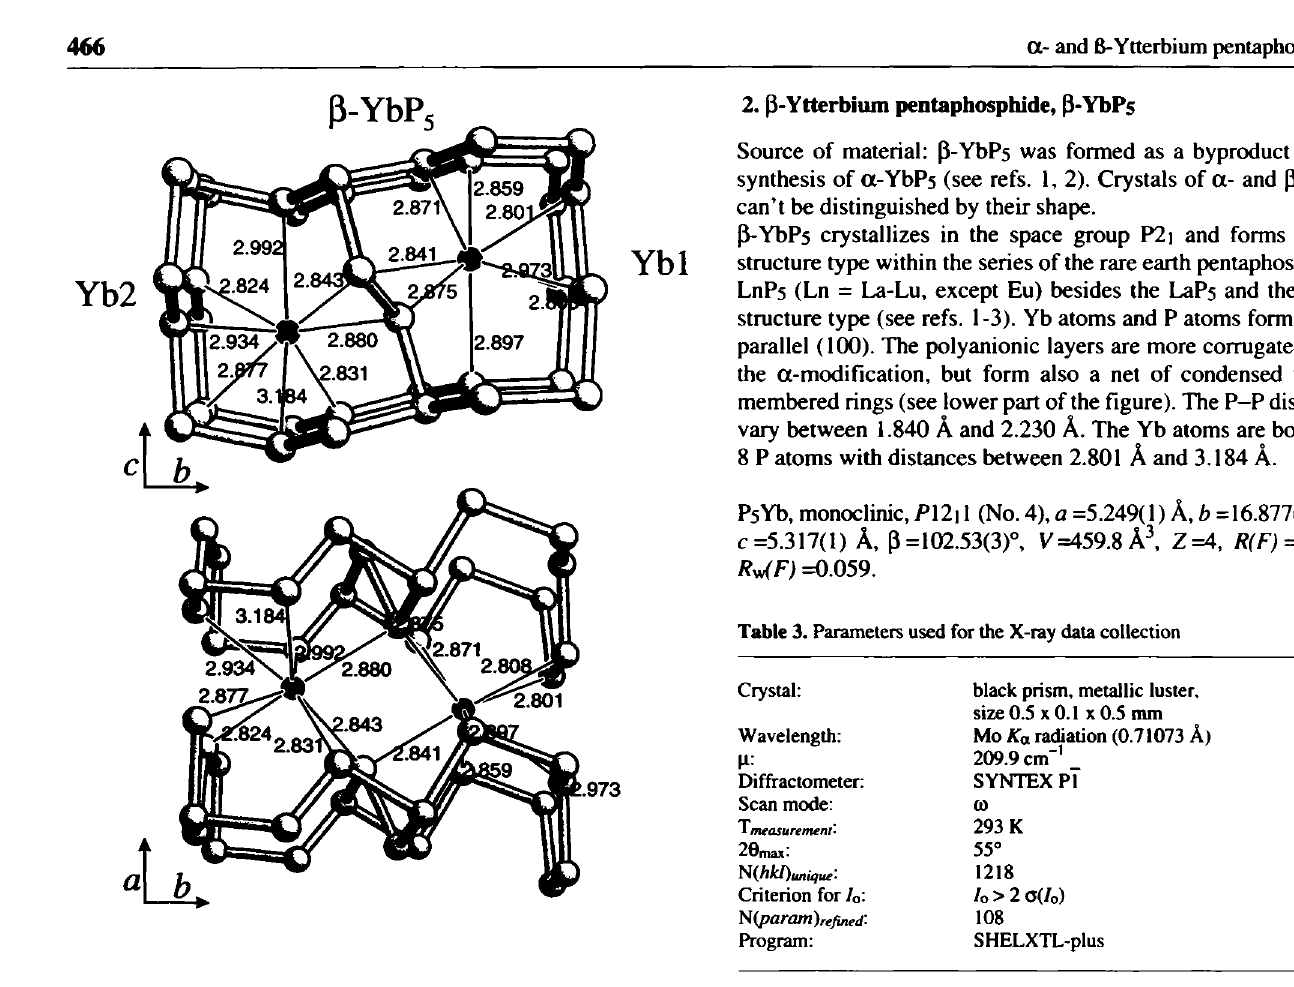
Table 4. Final atomic coordinates and displacement parameters (in